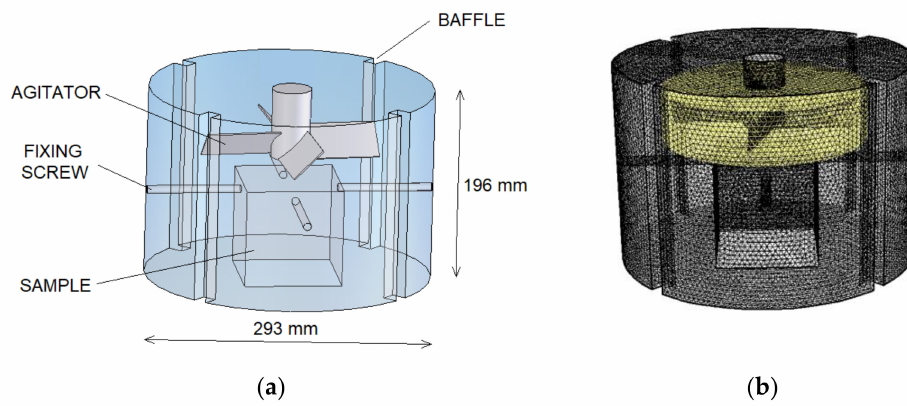
Figure 6. ( a ) Geometry of the experimental test; ( b ) computational mesh.